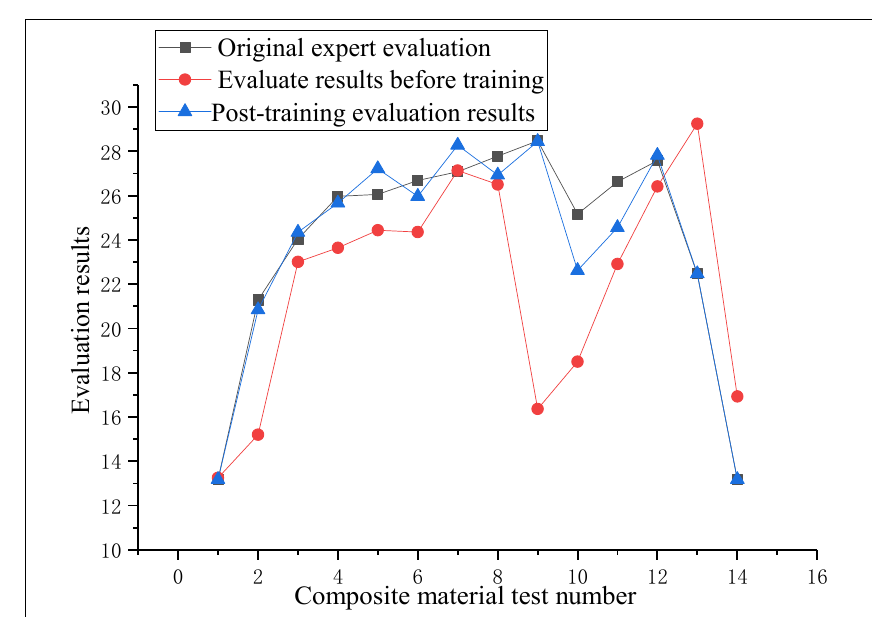
Figure 10. Comparison between system output before and after training and expert opinion.